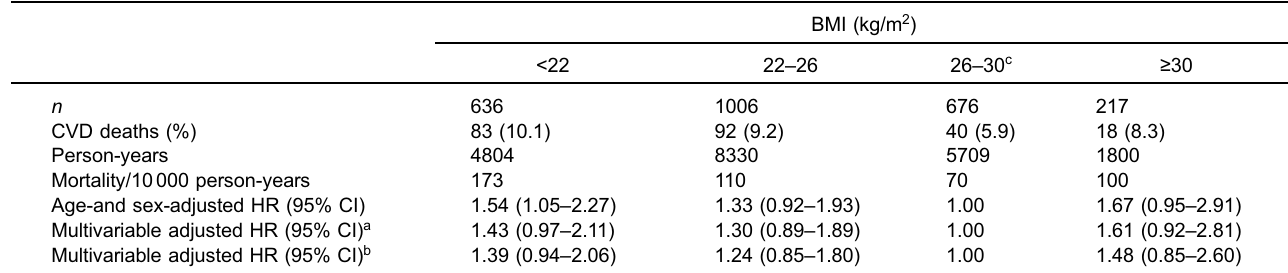
Table 3. Hazard ratio of CVD mortality according to di ff erent levels of BMI among patients with